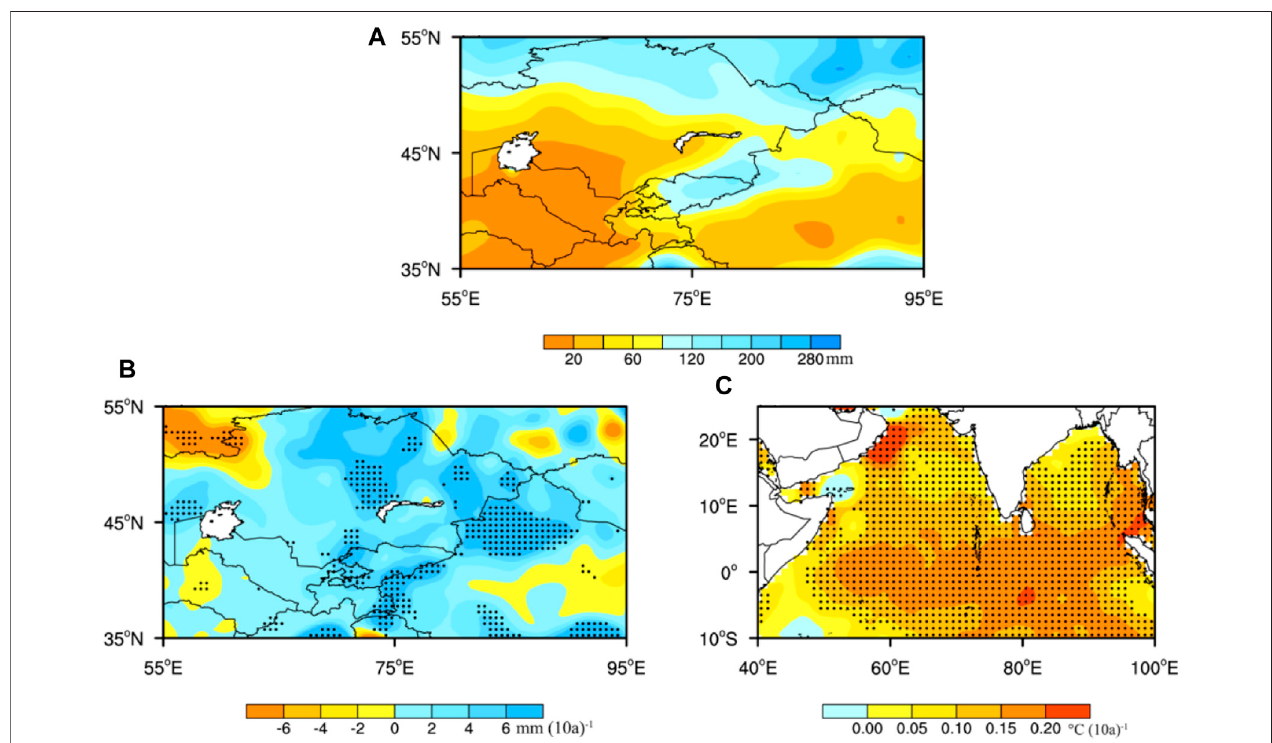
FIGURE 1 | (A) Distribution of mean summer rainfall over CA during 1971 – 2016, (B) linear trend of summer rainfall over CA during 1971 – 2016, (C) as (B) but for SSTs in the tropical IO. Dotted regions show signi fi cance at α (cid:2) 0 . 05 level.